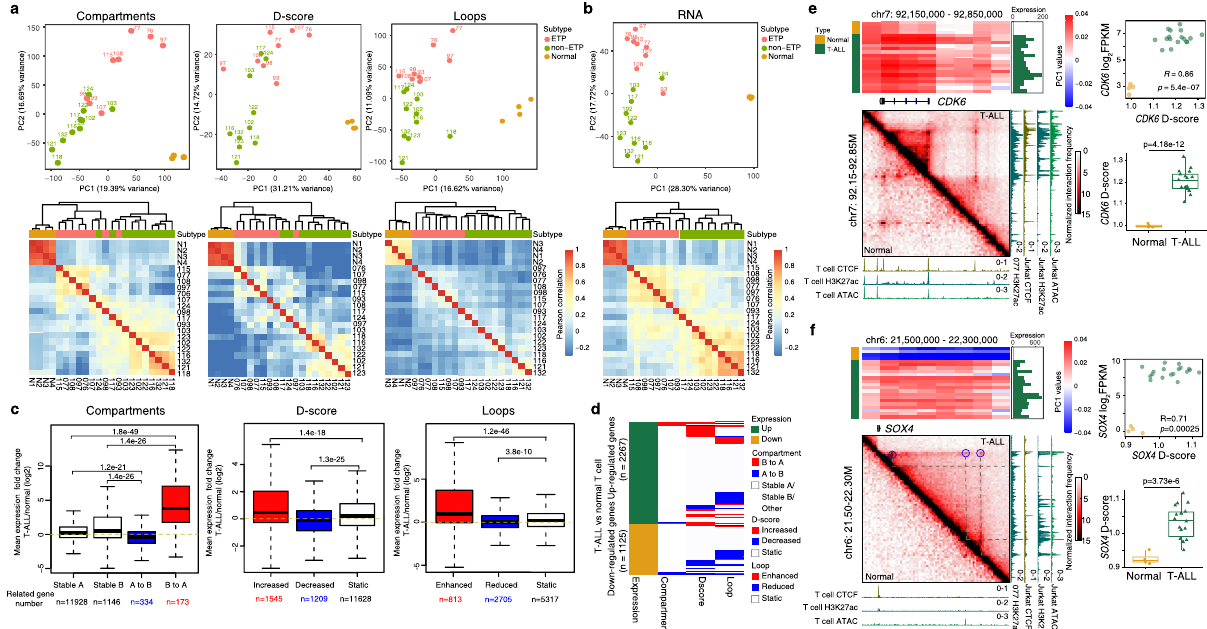
Fig. 1 3D genome architectures in T-ALLs. PCA (upper) and unsupervised hierarchical clustering analyses (lower) of compartment, domain score (D- score), and loop ( a ) and gene expressions ( b ) in normal T cells and T-ALLs. c Association of DEGs and genomic alterations at the levels of compartment, TAD, and loop. Red, upregulated; blue, downregulated. P values were calculated using the one-sided Wilcoxon rank sum test. d A summary of DEGs and their corresponding chromatin structure changes. A or B compartments were de fi ned by the over 70% sample majority rule. “ Other ” refers to those states can not be de fi ned. e , f Left-top, heatmaps show the compartment scores for each sample across the genomic regions of the CDK6 and SOX4 loci, respectively. Bar plots on the right show the gene expression level of CDK6 and SOX4 for each sample. Left-bottom, Hi-C contact maps of the CDK6 and SOX4 loci in normal T cell and T-ALL, each condition is normalized by its cis interaction pairs; blue circles: enhanced loops in T-ALL. ATAC-seq = and ChIP- seq tracks of CTCF and H3K27ac of normal T cells and T-ALL Jurkat cells, and H3K27ac ChIP-seq tracks of case 077 are also included. Right-upper: domain scores are plotted against gene expression of CDK6 and SOX4 genes. P values were calculated using Pearson correlation. Right-lower: quanti fi cation of the domain scores across TAD region encompassing the CDK6 (normal T cells, n = 4 and T-ALL, n = 17. Sample 108 is excluded from e as it has CDK6 related translocation) and SOX4 genes in all samples (normal T cells, n = 4 and T-ALL, n = 18). Statistical signi fi cance was calculated using the two-sided t -test. In c, e , and f , data are represented as boxplots where the middle line is the median, the lower and upper hinges correspond to the fi rst and third quartiles, the upper whisker extends from the hinge to the largest value no further than 1.5 × IQR from the hinge (where IQR is the inter-quartile range), and the lower whisker extends from the hinge to the smallest value at most 1.5 × IQR of the hinge, while data beyond the whiskers were ignored in c